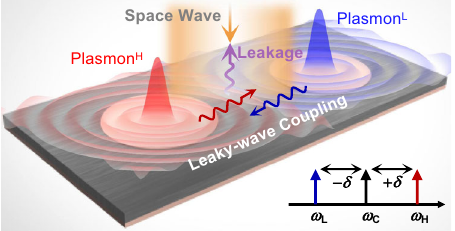
Fig. 1 | Schematicofthe radiative plasmonicAPTdesign. The systemconsists of two plasmonic resonators, whose frequencies are oppositely detuned, i.e. up- detuned( ω H )plasmon H anddown-detuned( ω L )plasmon L . ω C denotestheaveraged frequency ω C =( ω Η + ω L )/2. The two resonators are indirectly coupled by leaky waves, whose out-of-plane radiation leakage enables the interaction of the APT system and space waves.